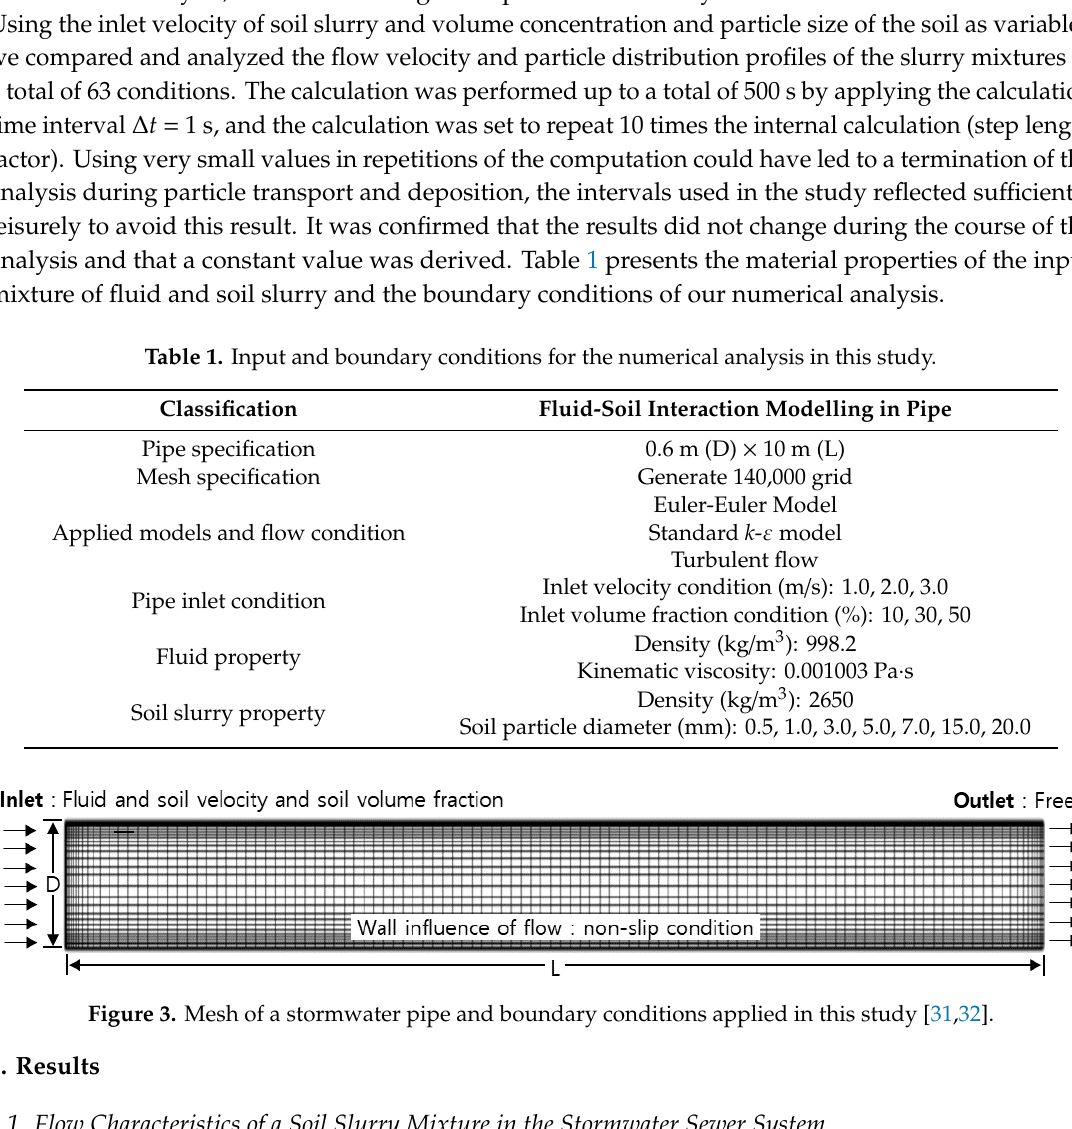
Table 1. Input and boundary conditions for the numerical analysis in this study.